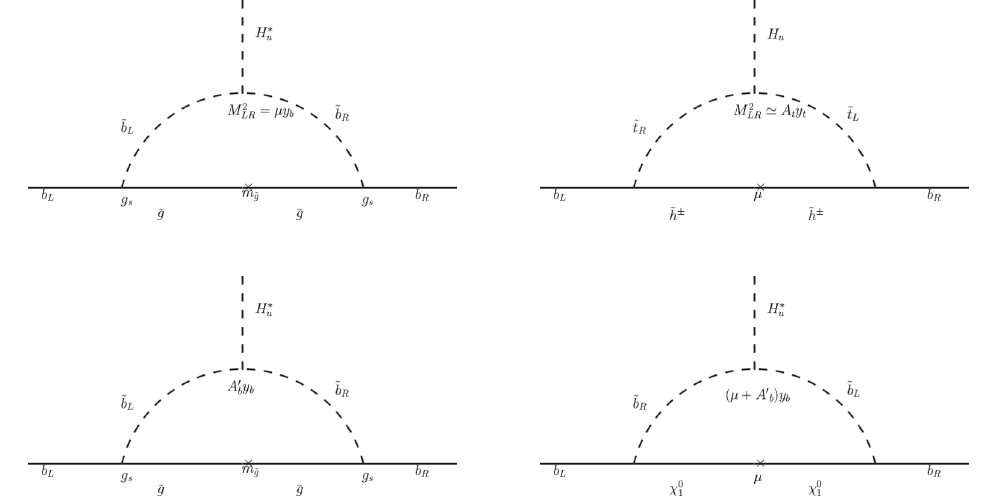
Figure 1 . The main diagrams for the one loop contribution to the bottom quark mass in MSSM (top planes) and the NHSSM (bottom planes)